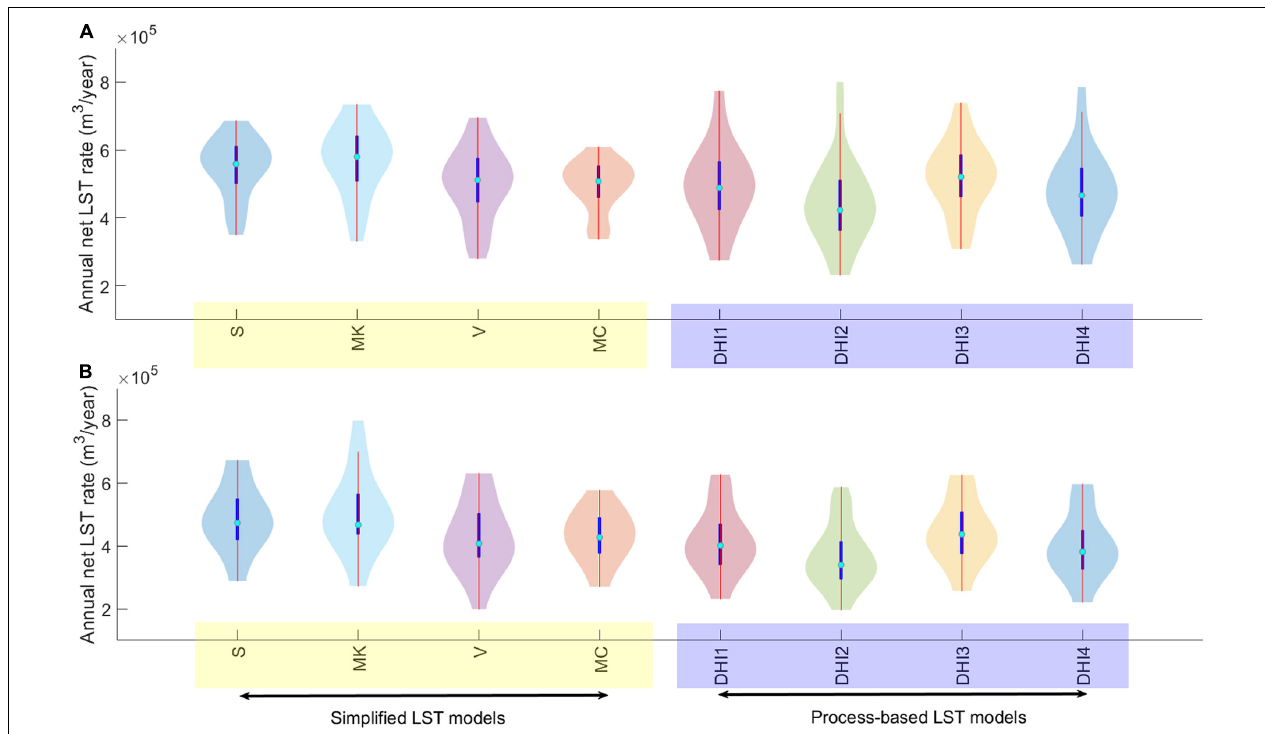
FIGURE 8 | Violin plots of the response of different LST modes to the dataset of MRI-CGCM3 driven waves at site D during (A) the baseline period and (B) the future period (under RCP 4.5). The violin plot shaded area is the approximation of the probability density function (PDF) through a kernel density estimation (KDE), while the remaining information corresponds with that of a boxplot. Bias-corrected forcing conditions were used for the